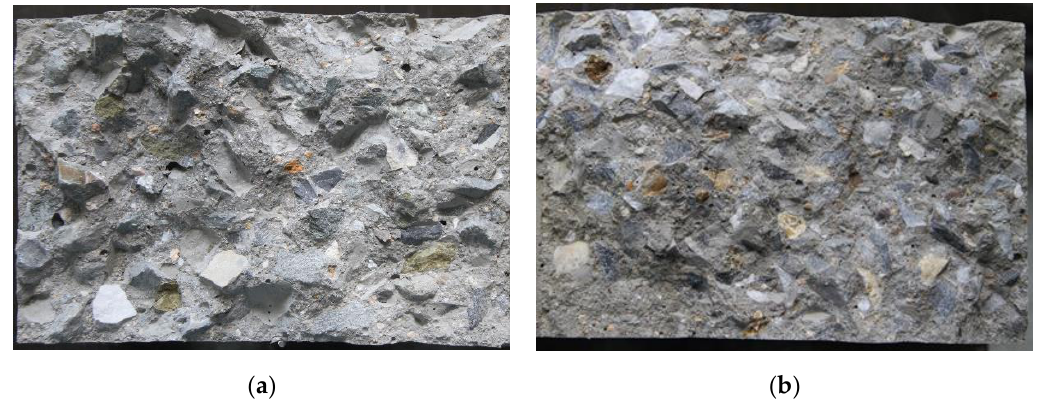
ff erent ages: ( a ) at 3 d; ( b ) at 60